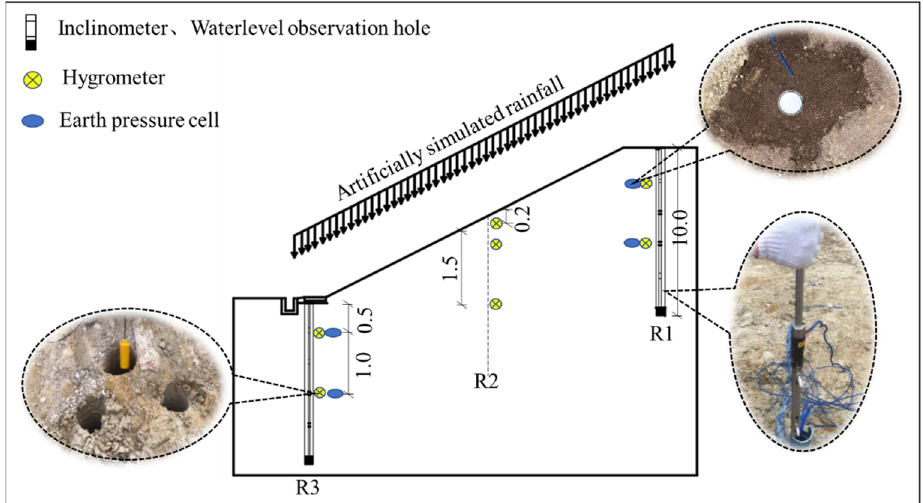
Figure 8. Sensor layout (side